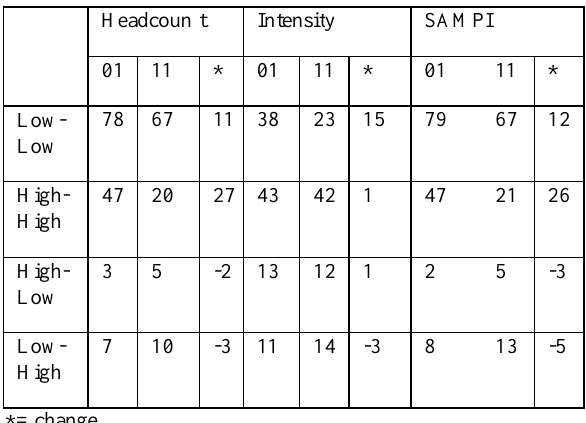
*= change Table 2. Assessing change in concentration of poverty between